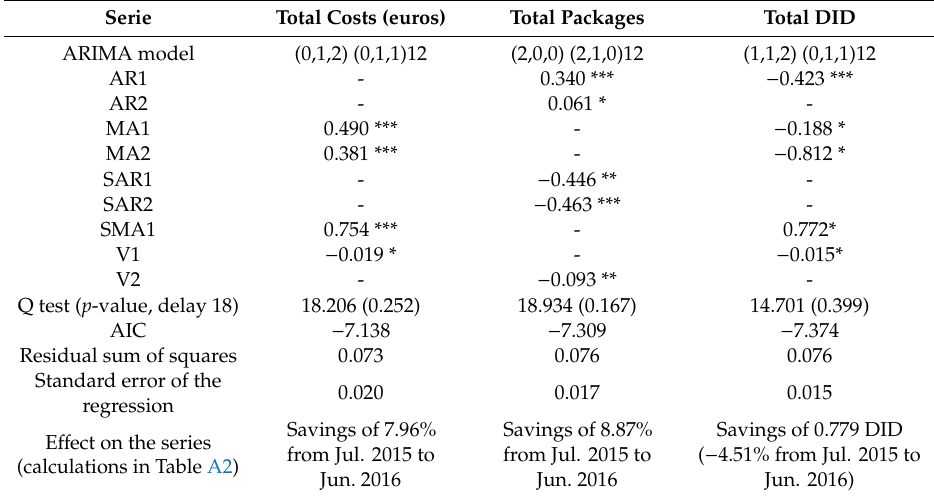
Table 2. National Program Against Bacterial Resistance (PRAN) approval, intervention analysis of the series of costs, packaging, and DID. Real values from January 2009 to June 2015 and predictions from July 2015 to June 2016 with dummy variables V1 and V2. Serie Total Costs (euros) Total Packages Total DID ARIMA model (0,1,2) (0,1,1)12 (2,0,0) (2,1,0)12 (1,1,2) (0,1,1)12 AR1 - 0.340 *** − 0.423 *** AR2 - 0.061 * - MA1 0.490 *** - − 0.188 * MA2 0.381 *** - − 0.812 * SAR1 - − 0.446 ** - SAR2 - − 0.463 *** - SMA1 0.754 *** - 0.772* V1 − 0.019 * - − 0.015* V2 - − 0.093 ** 18.206 (0.252) 18.934 (0.167) 14.701 (0.399) − 7.309 − 7.374 Residual sum of squares 0.073 0.076 0.076 Standard error of the 0.020 0.017 0.015 regression Savings of 7.96% Savings of 8.87% Savings of 0.779 DID E ff ect on the series from Jul. 2015 to from Jul. 2015 to ( − 4.51% from Jul. 2015 to (calculations in Table A2) Jun. 2016 Jun. 2016 Jun.